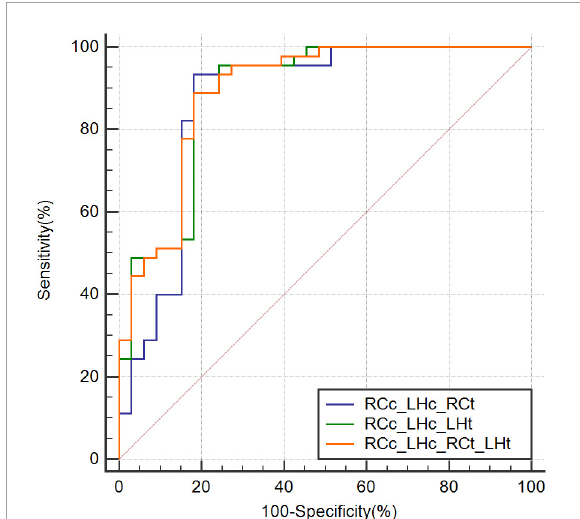
FIGURE5 Receiver operating characteristic curves combining three or more parameters. CBF, cerebral blood flow; RCc_LHc_LHt, CBF of right caudate nucleus and, CBF of left hippocampus, and T1 value of left hippocampus; RCc_LHc_RCt, CBF of right caudate nucleus and, CBF of left hippocampus, and T1 value of right caudate nucleus; RCc_LHc_RCt_LHt, CBF of right caudate nucleus and, CBF of left hippocampus, T1 value of right